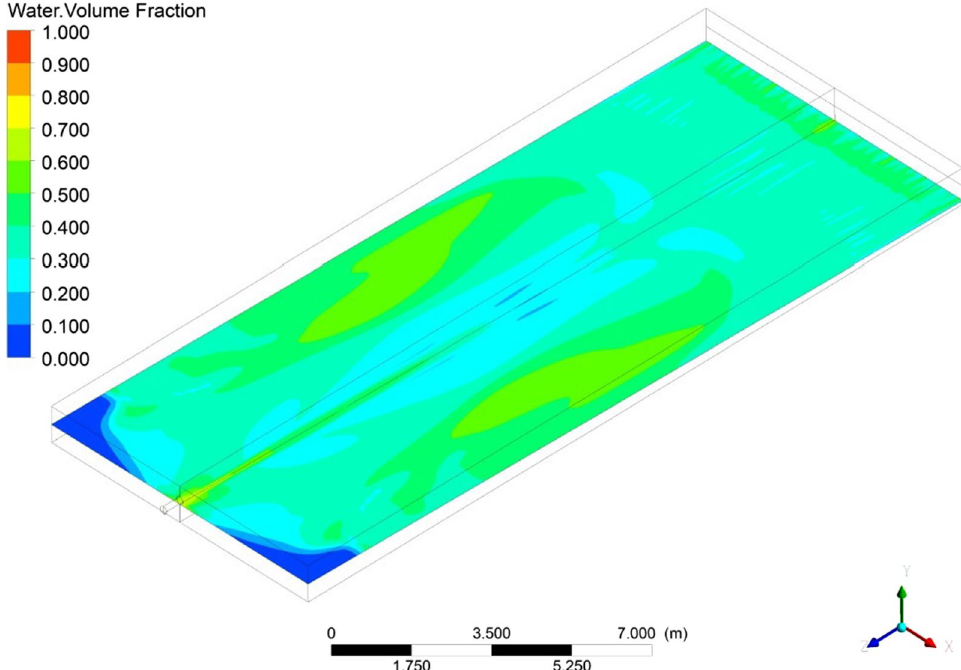
Fig. 13 Volume percentage of water at 81.515